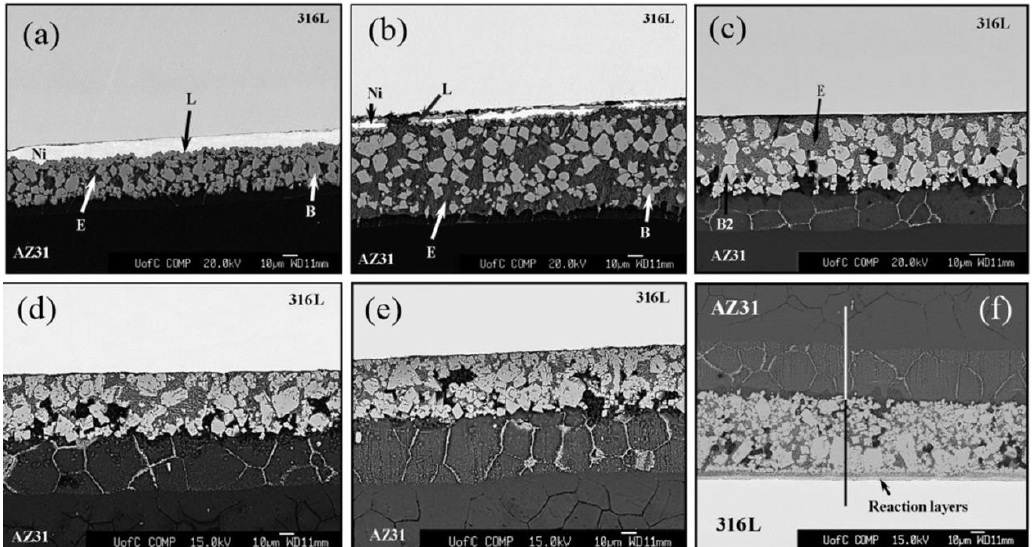
Figure 7. SEM micrographs of AZ31/Ni/316 L joint at 510 °C with different bonding time [27] ( a ) 3 min; ( b ) 5 min; ( c ) 10 min; ( d ) 20 min; ( e ) 30 min; ( f ) double stage bonding of 316 L/Ni/AZ31 with 20 min bonding time.